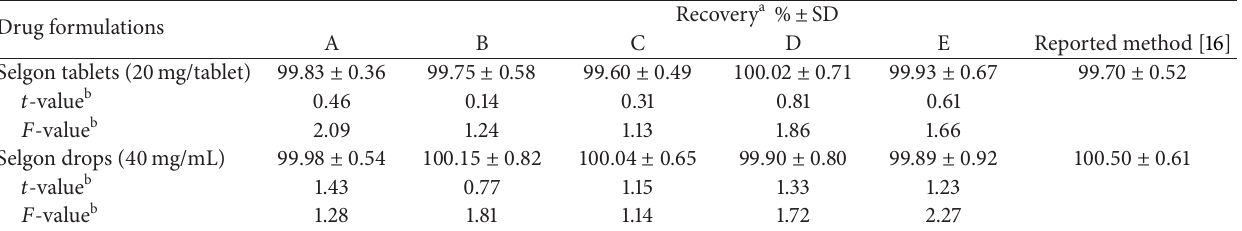
Table 6: Analysis of pharmaceutical formulations of PZT by the proposed and reported methods. Drug